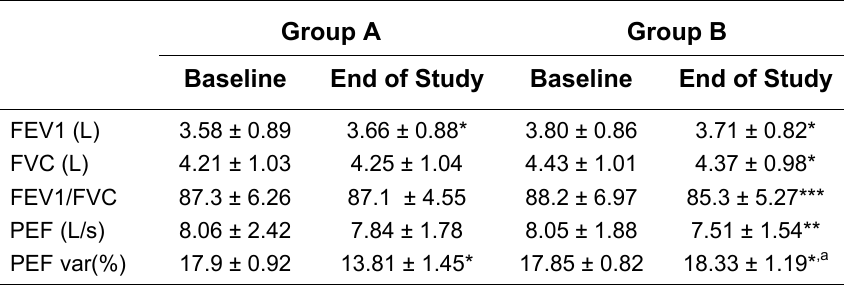
Lung Function, Initially and at the End of the Study Group A Group B Baseline End of